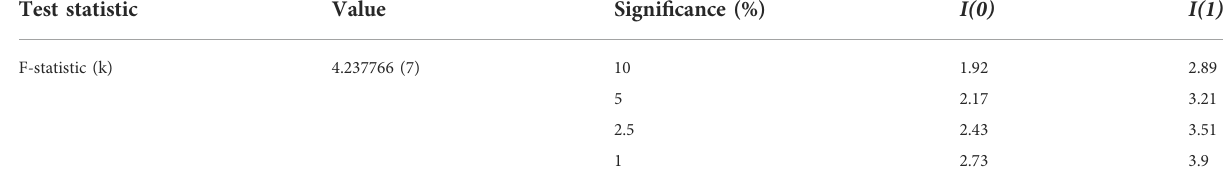
TABLE 6 ARDL bounds test co-integration (time series model).